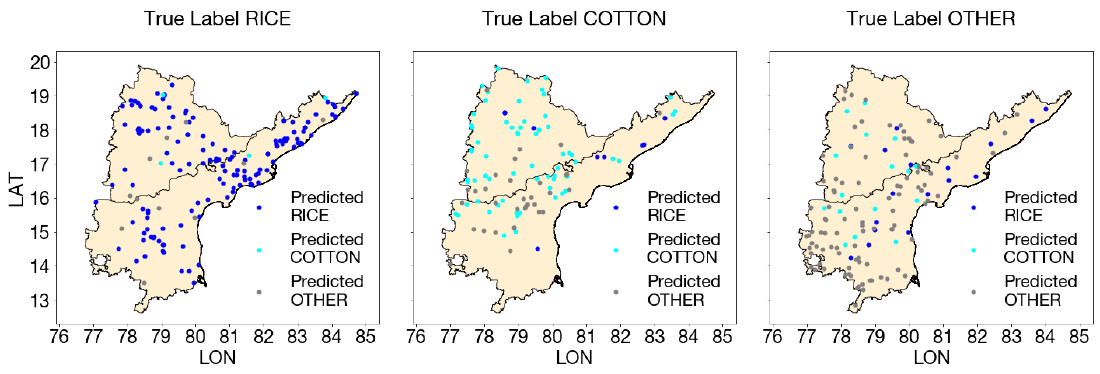
Figure A14. Map of 1D CNN predictions for rice, cotton, and other kharif crops. From left to right: panels show our model’s predictions for test points whose true labels are rice, cotton, and other,